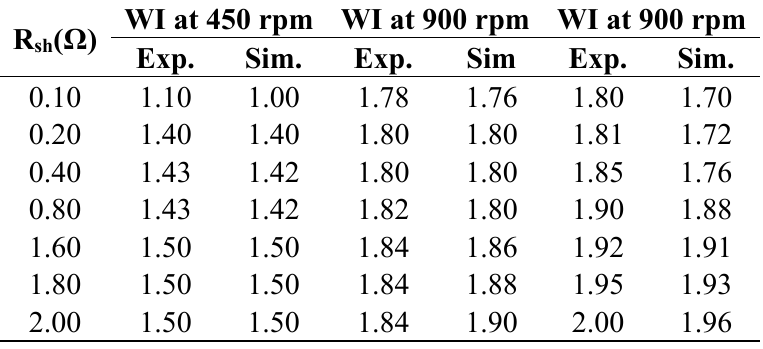
Table 2. Wavelet index (WI) for shunt Rs (0.1–2) for different